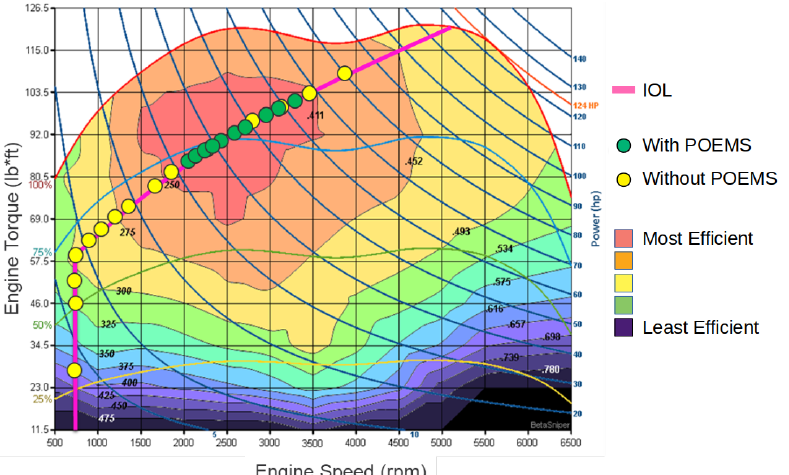
Figure 2. Example BSFC plot with IOL and operating points with and without